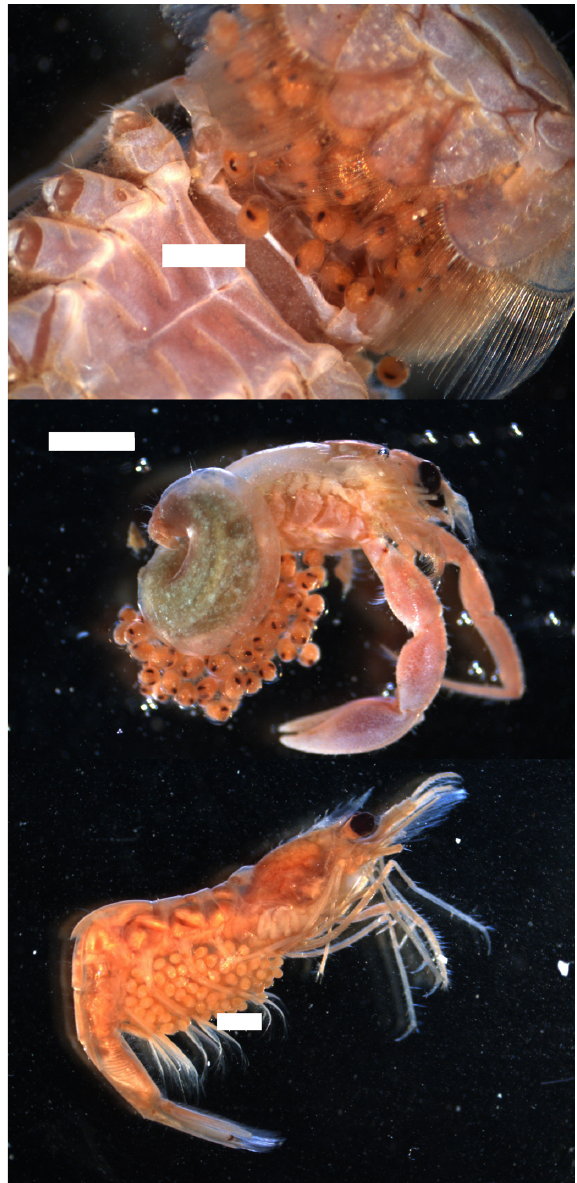
Fig. 5. Gravid decapod crustaceans on the reef complex. Top: the galatheid crab Munida sarsi , white scale = 1mm. Mid- dle: the hermit crab (shell removed) Pagurus forbesii , white scale = 2mm. Bottom: the pandalid shrimp Pandalina brevirostris , white scale =